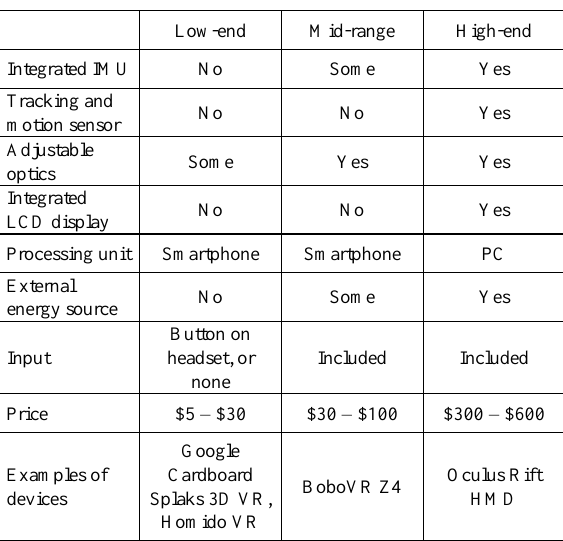
Table 1. Comparison of low-cost